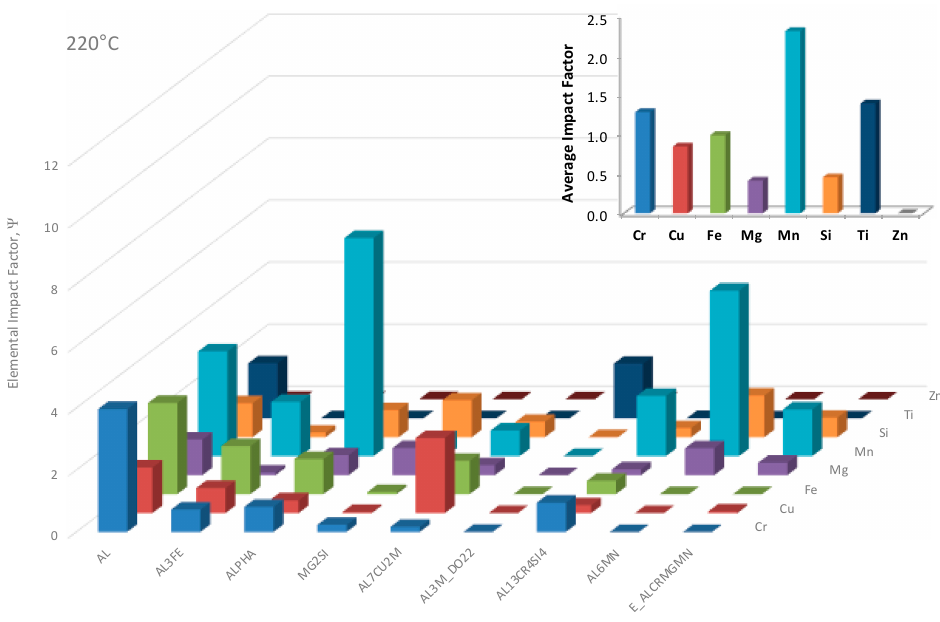
Figure 23. A multifaceted presentation of ψ s associated with given combinations of alloying elements in the Al 6061 system of interest and the equilibrium phases predicted at 220 ◦ C, which reflects the heat-treatable artificial aging temperature